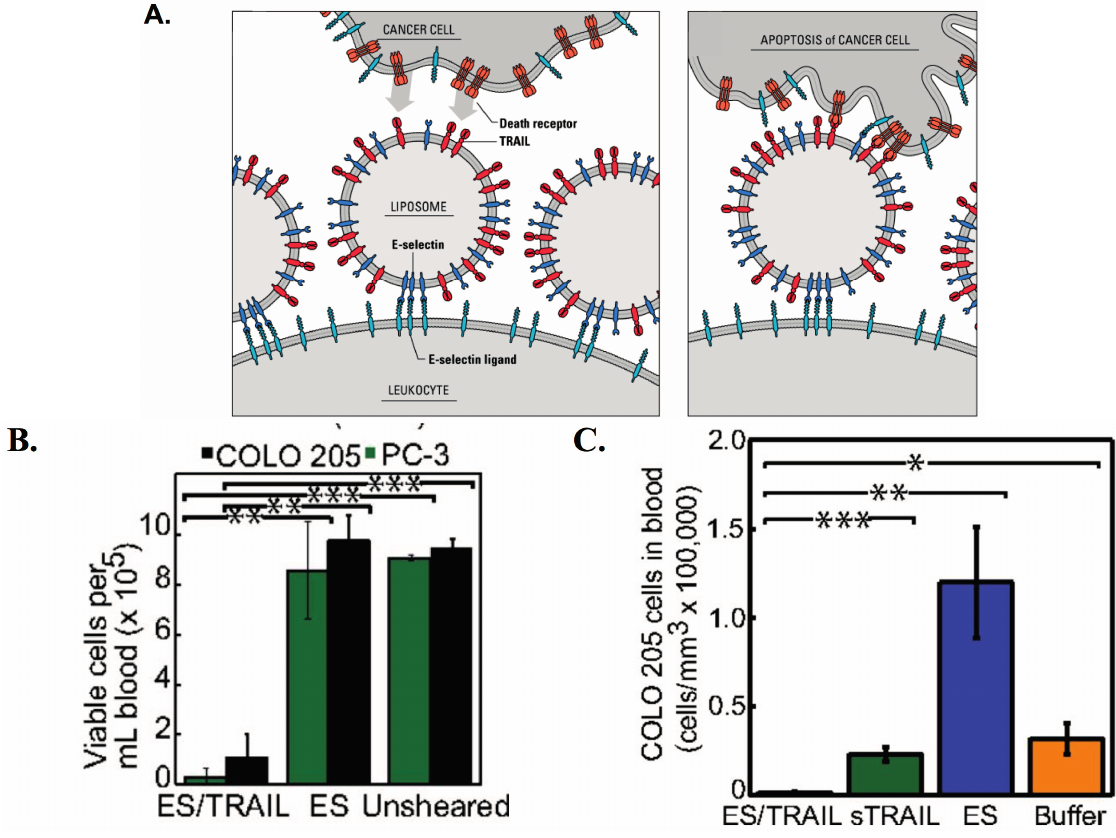
Figure 6. Targeting circulating tumor cells (CTCs) with TRAIL and E-selectin (ES) functionalized liposomes directed to leukocytes: ( A ) Schematic of the “unnatural killer cell” approach. ES/TRAIL liposomes bind to leukocytes expressing E-selectin ligands. Liposome-bound leukocytes (unnatural killer cells) induce apoptosis in cancer cells expressing death receptors during cellular collisions under flow. Adapted from Ref. [189]; ( B ) Number of viable PC-3 and COLO205 cancer cells per mL of blood after treatment with ES/TRAIL or ES liposomes under physiologically relevant shear conditions (188 s − 1 for 2 h); ( C ) Average number of viable COLO205 cells per mL of blood in mice treated with ES/TRAIL liposomes, soluble TRAIL, ES liposome or buffer injected with fluorescent COLO205 cells. * p < 0.01 ** p < 0.001, *** p < 0.0001 (unpaired t test); ( B , C ) Reproduced with permission from Ref.